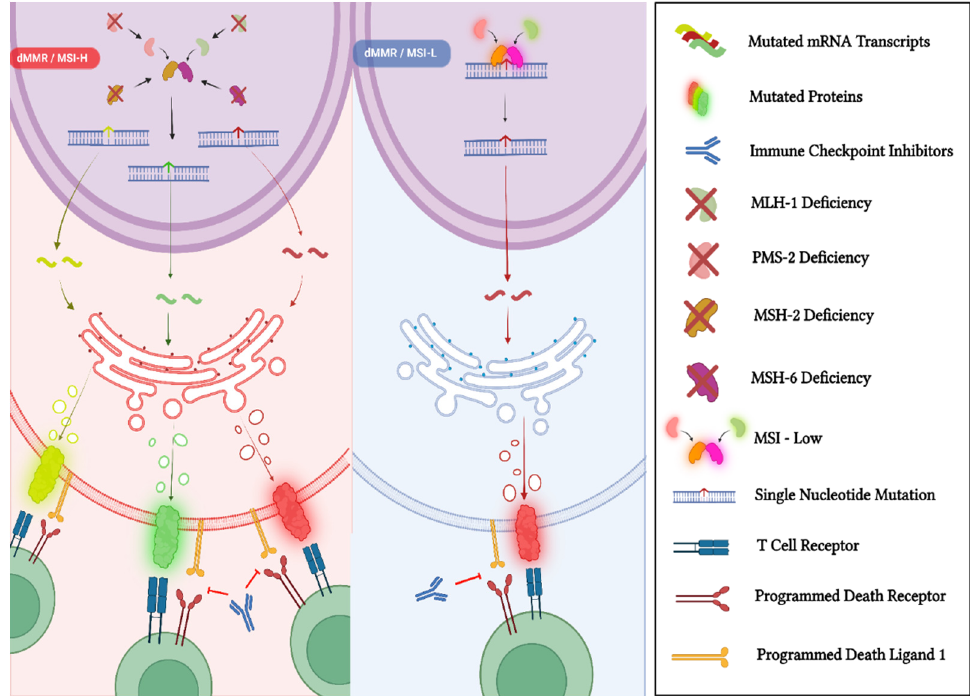
Figure 1. In normal cells, the MMR system guarantees DNA fidelity by detecting (MSH2/MSH6 complex) and repairing (MLH1/PMS2 complex) genetic mismatches that occurred during DNA replication. In contrast, dMMR/MSI-H tumor cells are not able to repair DNA mismatches in microsatellites and, consequently, are characterized by an accumulation of genomic alterations, which result in a higher quantity of neoantigens. This immunogenic phenotype is generated by a higher genomic mutational burden and provides dMMR/MSI-H tumors with an increased susceptibility to the reactivation of the anti-cancer response when treated with immune checkpoint